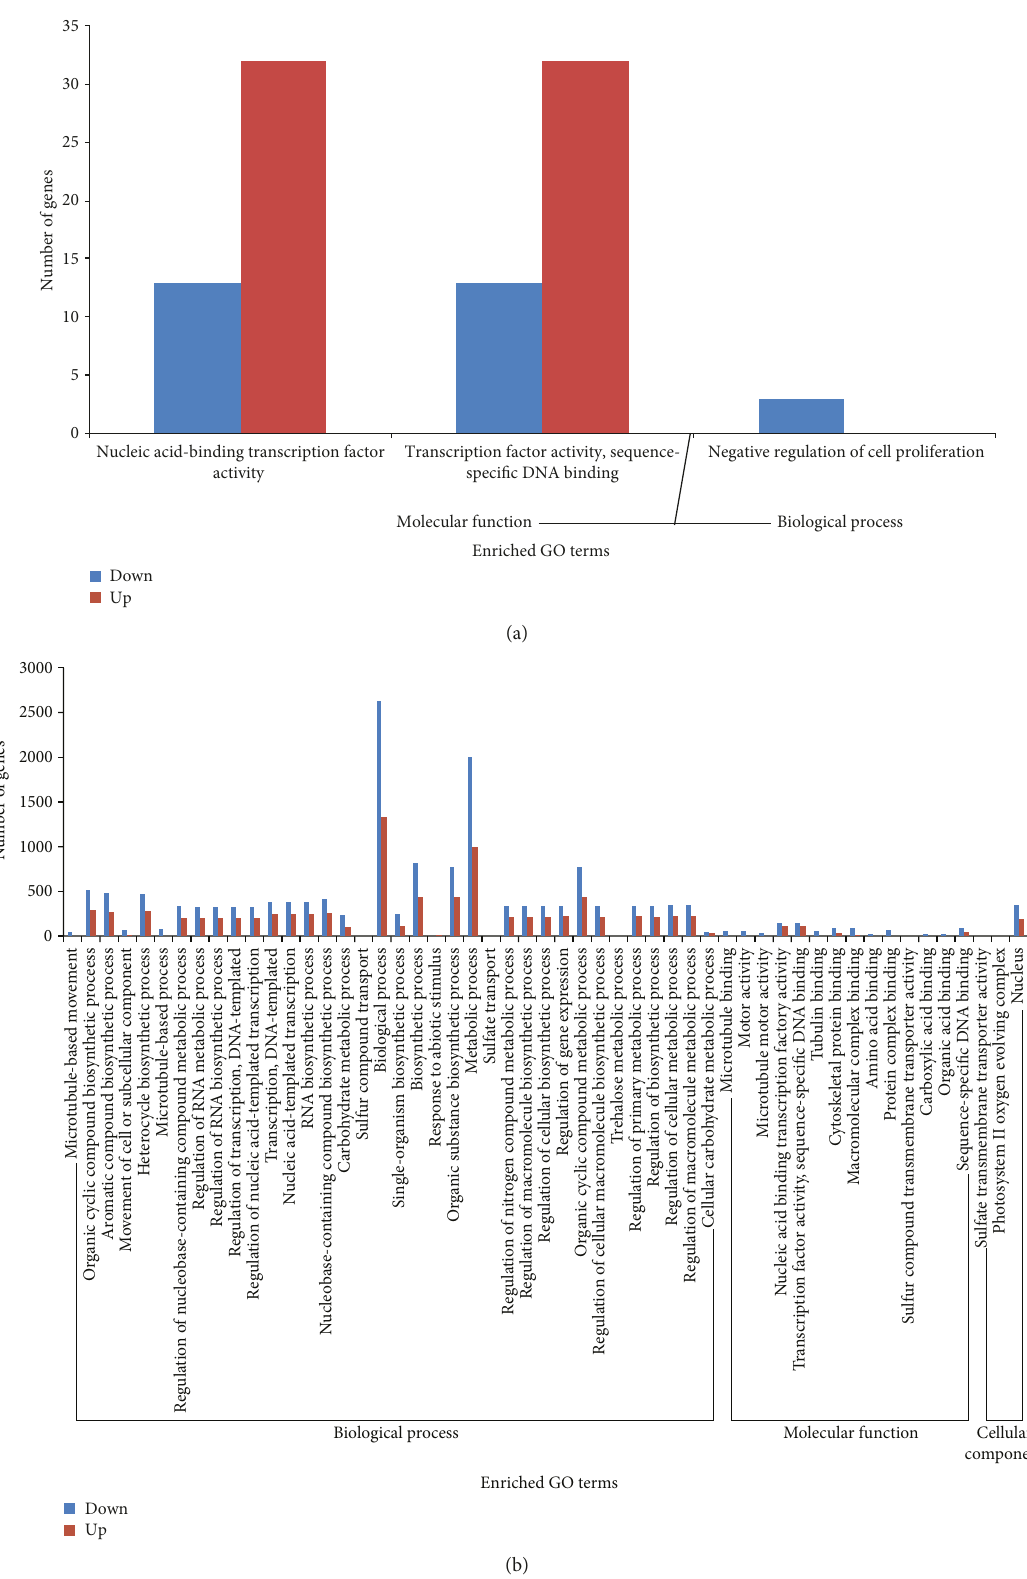
Figure 4: Clustering analysis diagram of signi fi cantly enriched GO terms from di ff erentially expressed genes between di ff erent samples. (a) Clustering analysis diagram of signi fi cantly enriched GO terms from di ff erentially expressed genes in L2vsL1. (b) Clustering analysis diagram of signi fi cantly enriched GO terms from di ff erentially expressed genes in